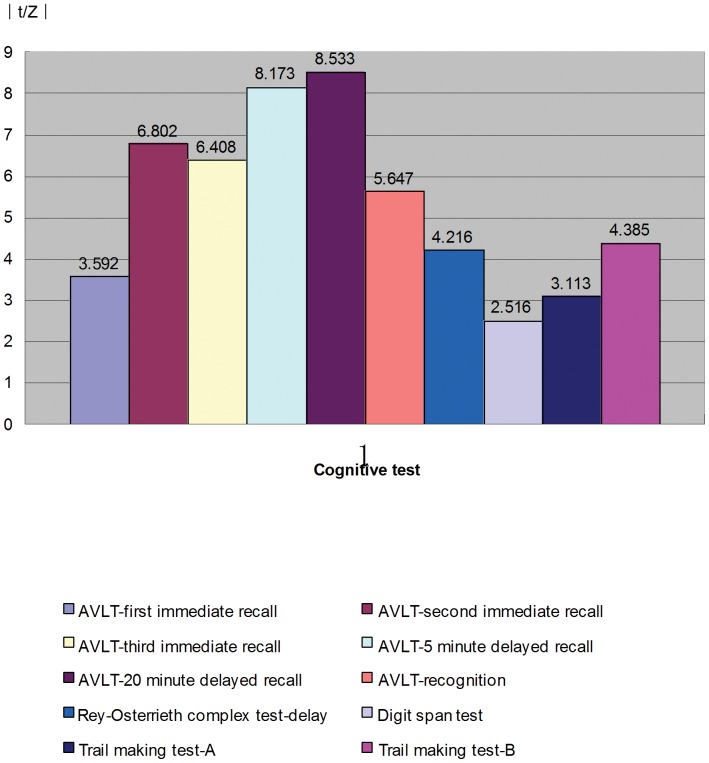
Comparison of cognitive performance between aMCI patients and normal controls.The scores from the neuropsychological tests (AVLT-first immediate recall, AVLT-second immediate recall, AVLT-third immediate recall, AVLT-5 minute delayed recall, AVLT-20 minute delayed recall, AVLT-recognition, Rey-Osterrieth complex test-delay, Digit span test, Trail making test-A, Trail making test-B) were significantly lower for the aMCI patients than for the normal controls (|t/Z| = 3.592, 6.802, 6.408, 8.173, 8.533, 5.647, 4.216, 2.516, 3.113, 4.385 respectively, all P<0.01).